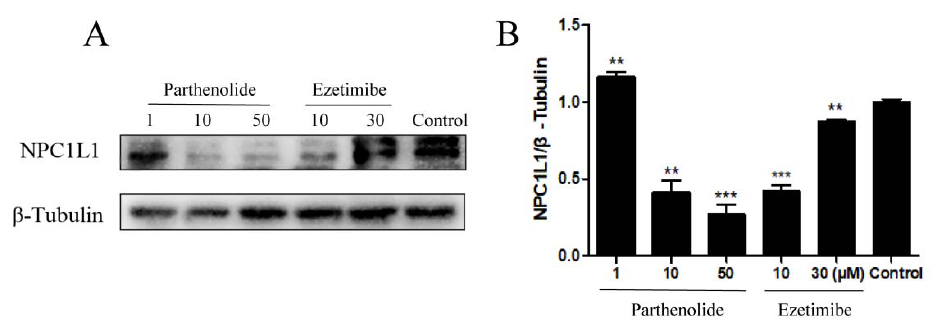
Figure 6. Effects of PTL on NPC1L1 protein expression in HepG2 cells. ( A ) Cells were treated with 1, 10, 50 µ M of PTL and 10, 30 µ M of ezetimibe for 24 h, followed by Western blot analysis of NPC1L1 in HepG2 cells. ( B ) A statistical representation of the Western blot showed that the expression of NPC1L1 was altered after PTL and ezetimibe treatments compared to controls. (** p < 0.01, *** p < 0.001 compared to control).